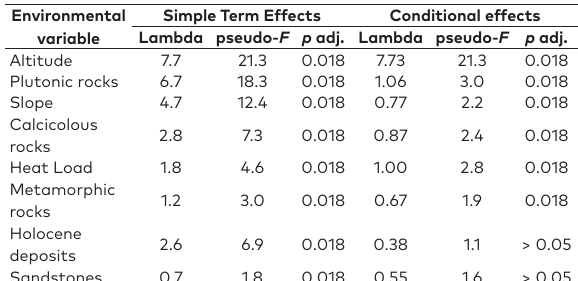
Figure 8. db-RDA plot of samples of the tall-herb com- munities of the Sudetes Mts. and their foothills (SW Poland) overlaid with environmental variables. Symbols indicate alliances: circles: Petasition officinalis (1: Geranio phaei-Urticetum , 2: Petasitetum hybrydi , 3: Chaerophylo hirsuti-Petasitetum albi ; 4: Prenanthetum purpureae ); tri- angles: Rumicion alpini (5: Rumicetum alpini ); diamonds: Calamagrostion villosae (6: Poo chaixii-Deschampsietum , 7: Athyrietum filicis-feminae , 8: Crepido conyzifoliae-Cal- amagrostietum ); squares: Adenostylion alliariae (9: Ci- cerbitetum alpin ae) Table 3. The simple term and conditional effects of ana- lyzed environmental variables on species composition of the distinguished montane tall-herb communities, iden- tified using db-RDA with SQRT Jaccard binary distance and Monte Carlo permutation test. Lambda - variance ex- plained by the environmental variable [in %], p adj.: p with Bonferroni correction.